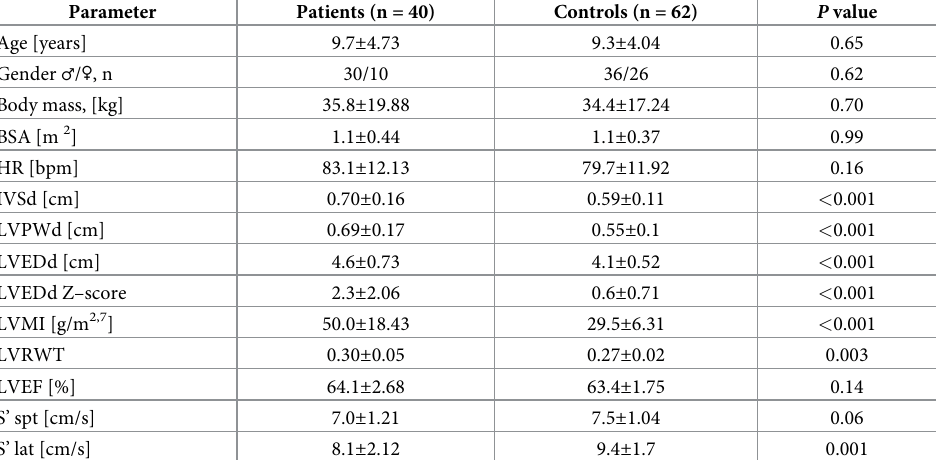
Table 1. Clinical characteristic of the study population, conventional and tissue Doppler echocardiographic mea- surements of left ventricle.